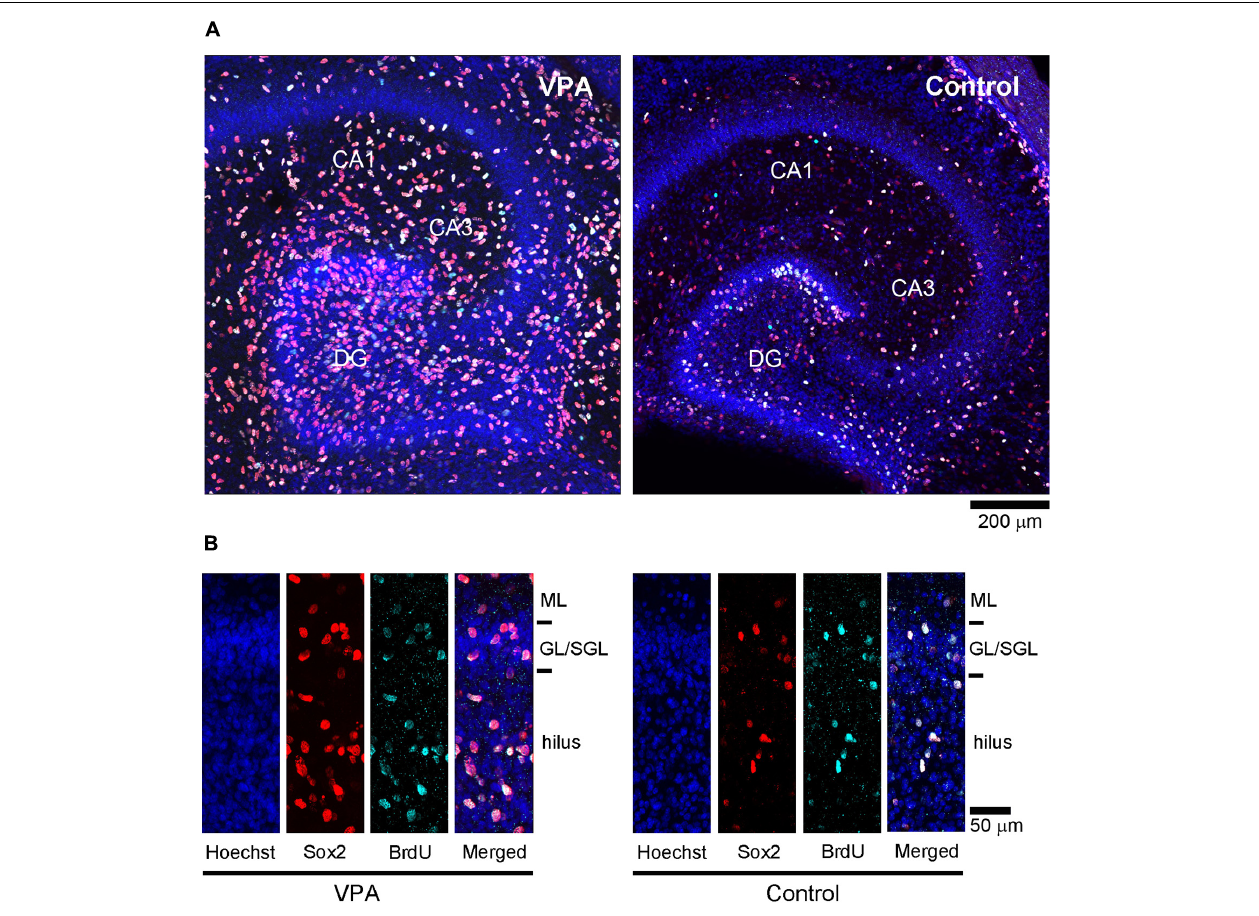
FIGURE 4 | Sox2 immunofluorescence with 5-bromo-2-deoxyuridine (BrdU)-labeling and Hoechst staining in premature hippocampus of postnatal day (PD) 7 ferrets. (A) Low-magnification images in the premature hippocampi of valproic acid (VPA)-treated (left) and control (right) ferrets. (B) High-magnification images of Sox2 immunofluorescence with BrdU-labeling and Hoechst staining in the dentate gyrus in VPA-treated (left) and control (right) ferrets. GL, granular layer; ML, molecular layer; SGL, subgranular